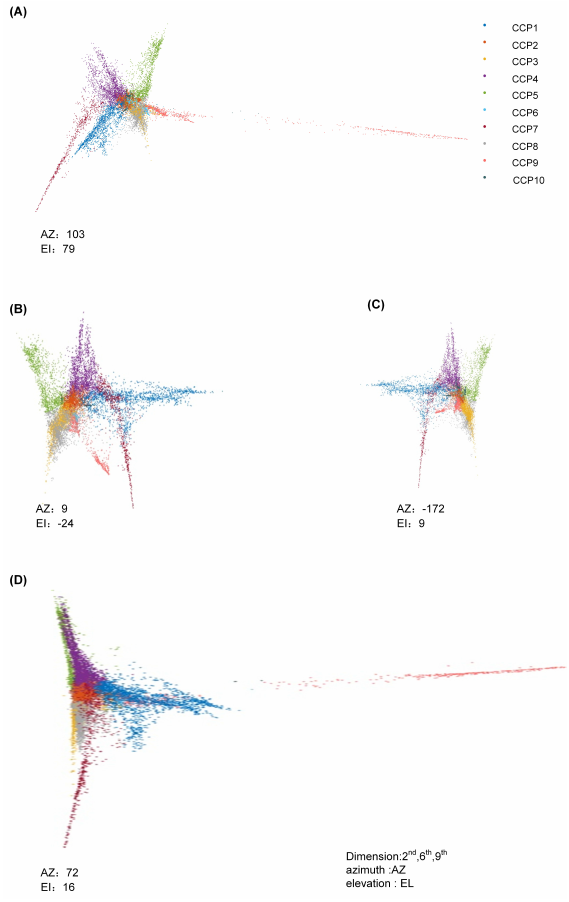
Figure A5. The 3D plot of the manifold viewed from different angles for the 10 CCPs in the 2 nd ,6 th ,9 th dimension.